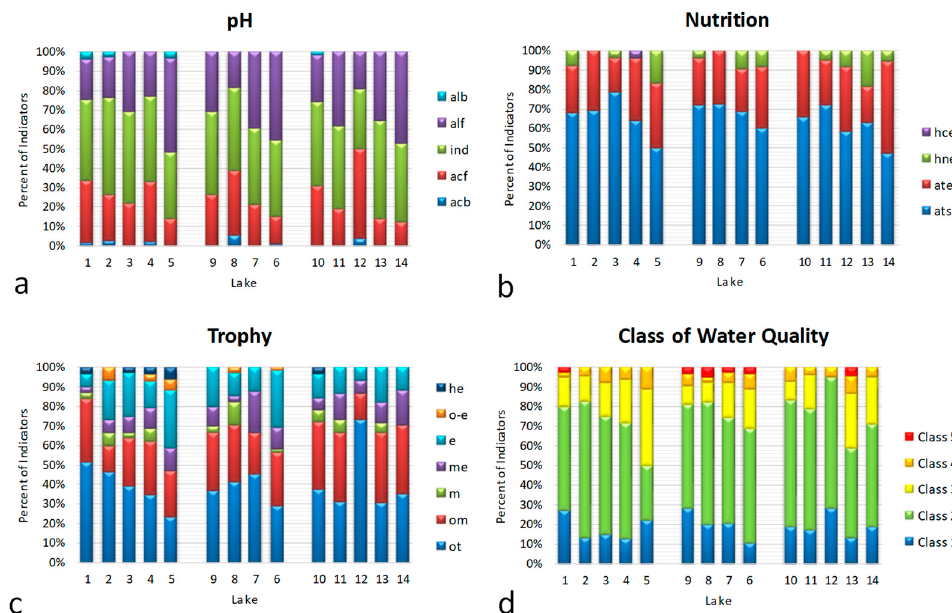
Figure 3. Bioindicator distributions in the 14 studied water bodies: ( a ) pH (alb—alkalibiontes; alf—